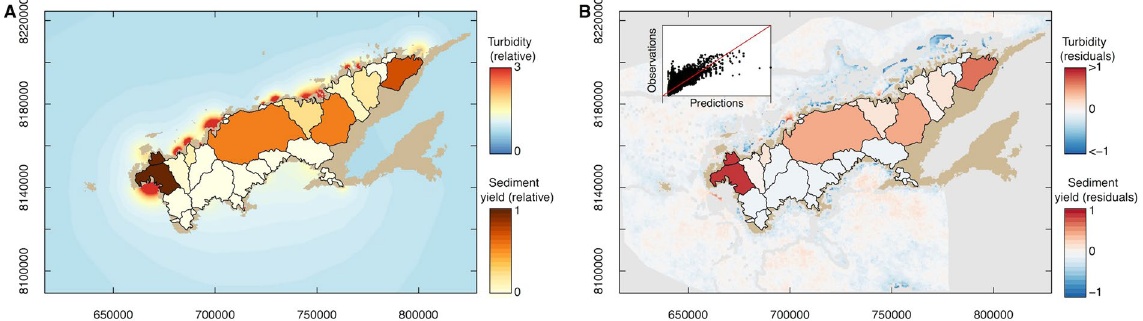
Figure 2. Predicted ( A ) and residual ( B ) catchment yields and turbidity values from the model fit for Vanua Levu. The inset on B show a plot of predicted versus residual values. Sediment yields in ( A ) and residual yields in ( B ) are scaled relative to the maximum yield value. Residuals for turbidity in ( B ) are constrained in [ − 1, 1] to aid visualization, because there were more negative residuals ( − 4) at the mouth of the Dreketi river. The maps were created using the spatial data described in text and the R programming language (R: A language and environment for statistical computing. v3.3.2 (R Foundation for Statistical Computing, Vienna, Austria., 2016).